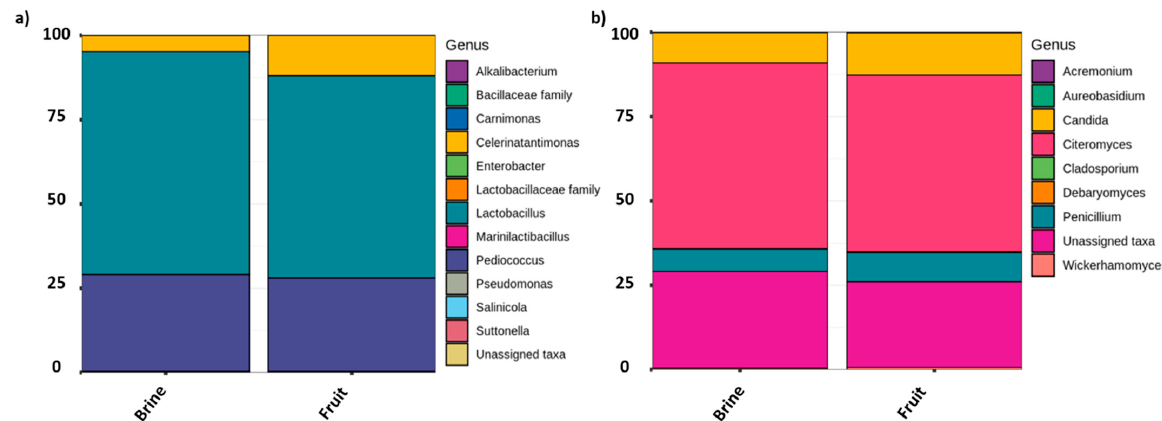
Figure 3. Relative abundance of sequences (%) to different taxa levels, obtained by metataxonomic analysis from 16S ( a ) and ITS ( b ) data samples of traditional packed Aloreña de Málaga . Values obtained for brine (n = 16) are means from n=8 independent samples for both bacteria and fungi, while fruits ( n = 13) were n = 7 for bacteria and n = 6 for fungi. Only those taxa with abundance >0.1% in at least one sample are shown. Data were generated by grouping all sampling times. Microorganisms 2021 , 9 , x FOR PEER REVIEW